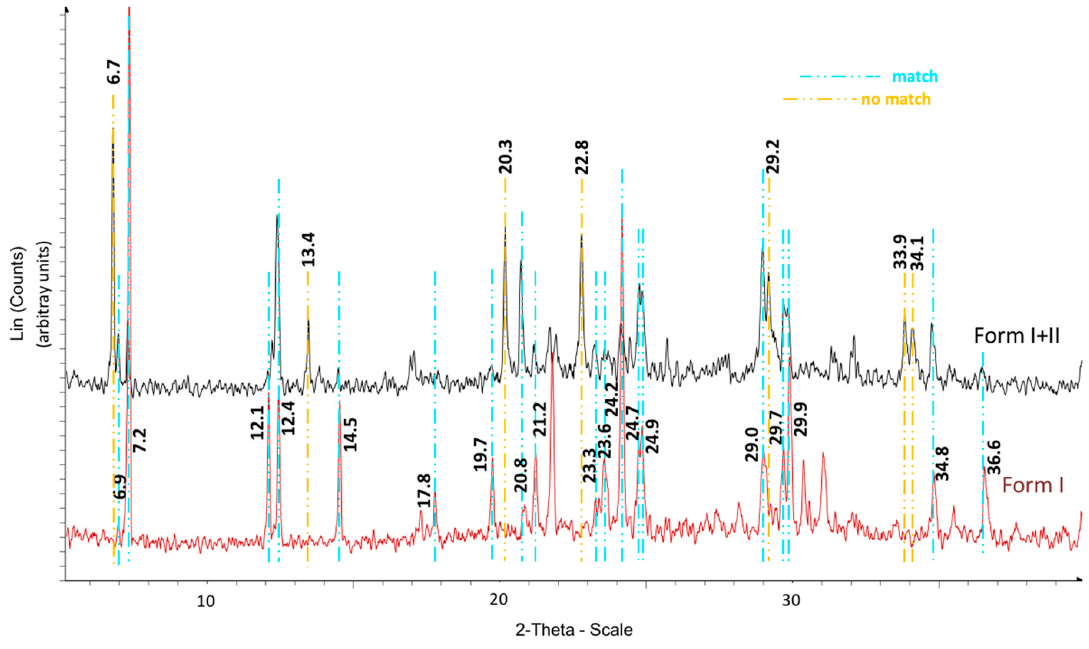
Figure 3. X-ray diffractograms for compound VA6E. Form I shows the diffractogram of the original polymorph and Form I + II, the one obtained after one cycle of